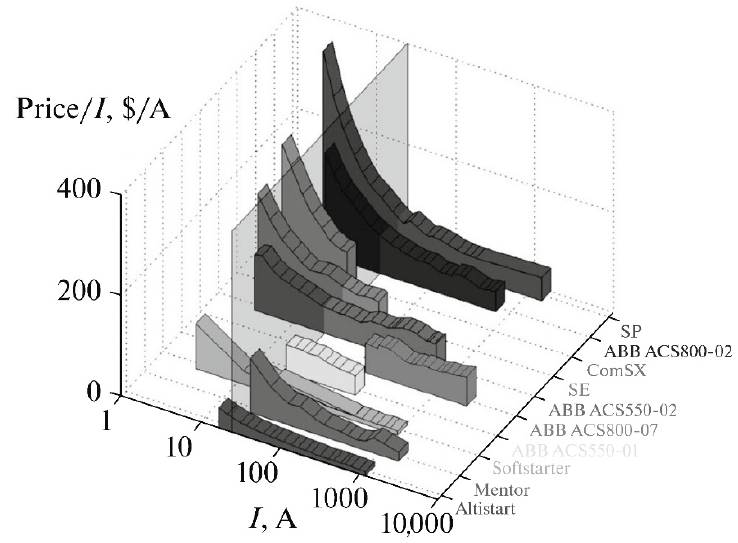
Figure 7. Functions of the specific cost of semiconductor converters from the current load